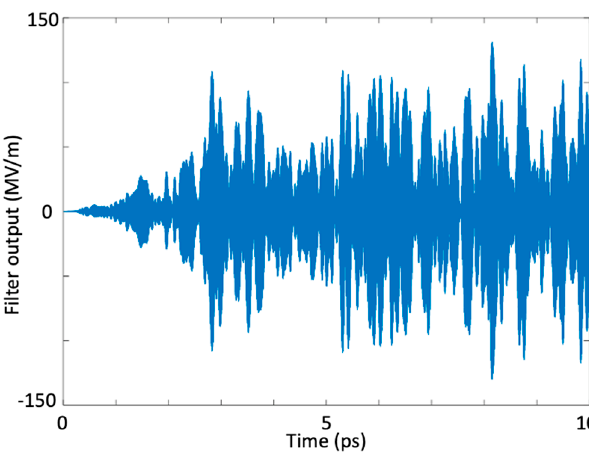
Figure 8 . Time variation of the maximum amplitude at the band-pass filter output (harmonic generation at 515 THz).